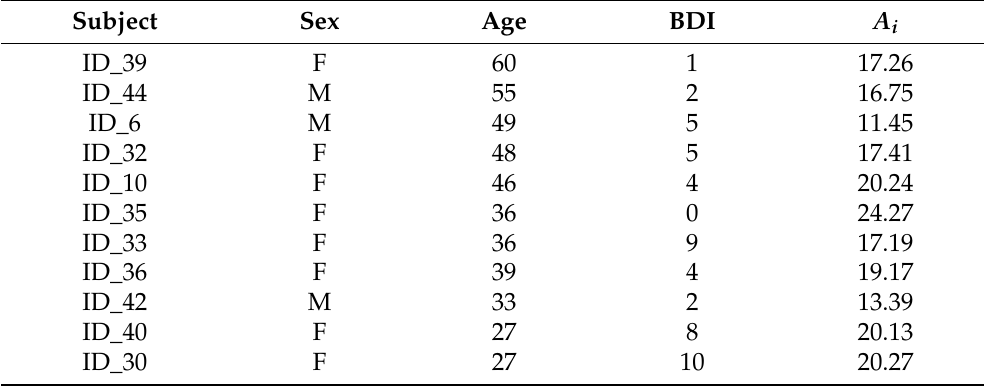
Table 3. Average variations ( A i ) in non depressed subjects.